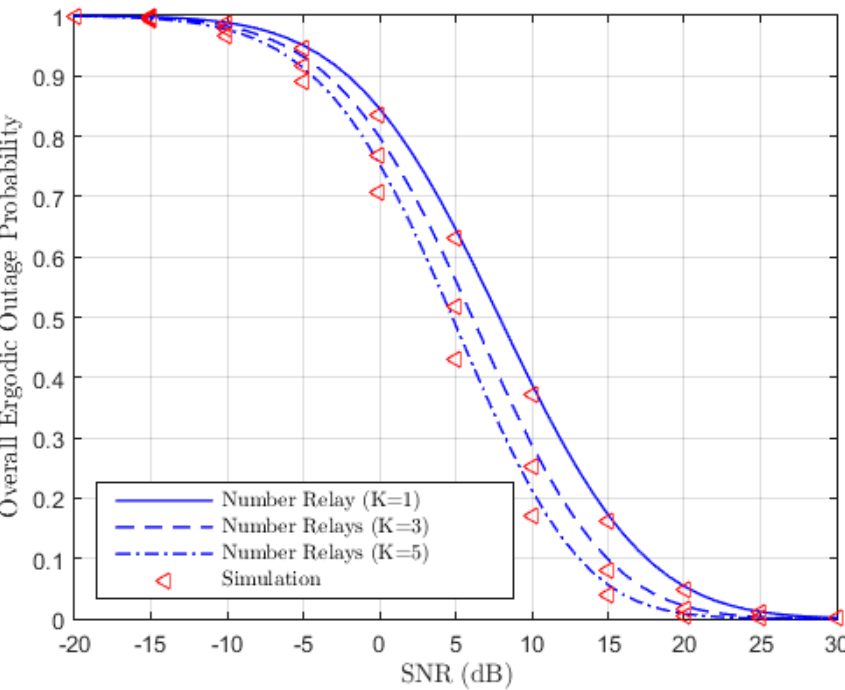
Figure 6. Relation between the overall ergodic OP and the SNR, with three K